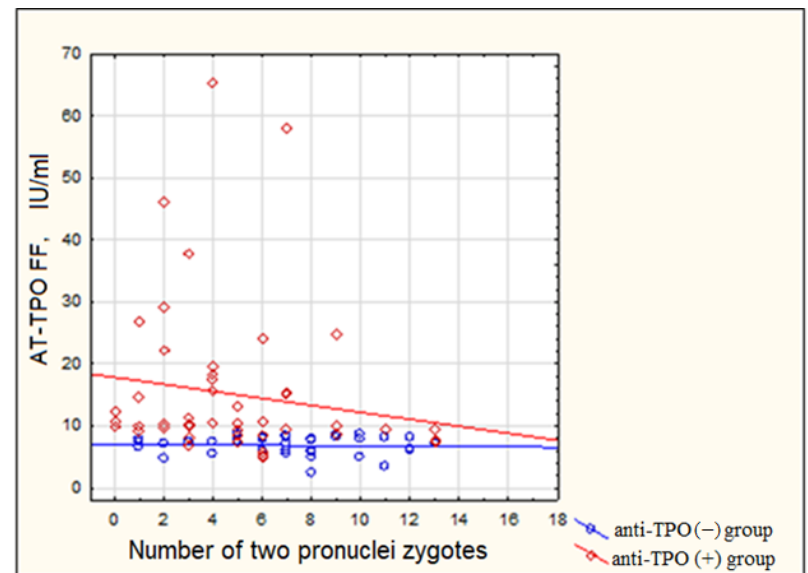
Figure 4. Association between the number of 2PN zygotes and follicular fluid AT-TPO values in both groups. AT-TPO—anti-thyroid peroxidase antibody; FF—follicular fluid. Data on comparative analysis of daily embryological outcomes in the setting of IVF (IVF/ICSI) among both groups is presented in Table Table 5. Comparative analysis of embryological outcome in groups investigated.